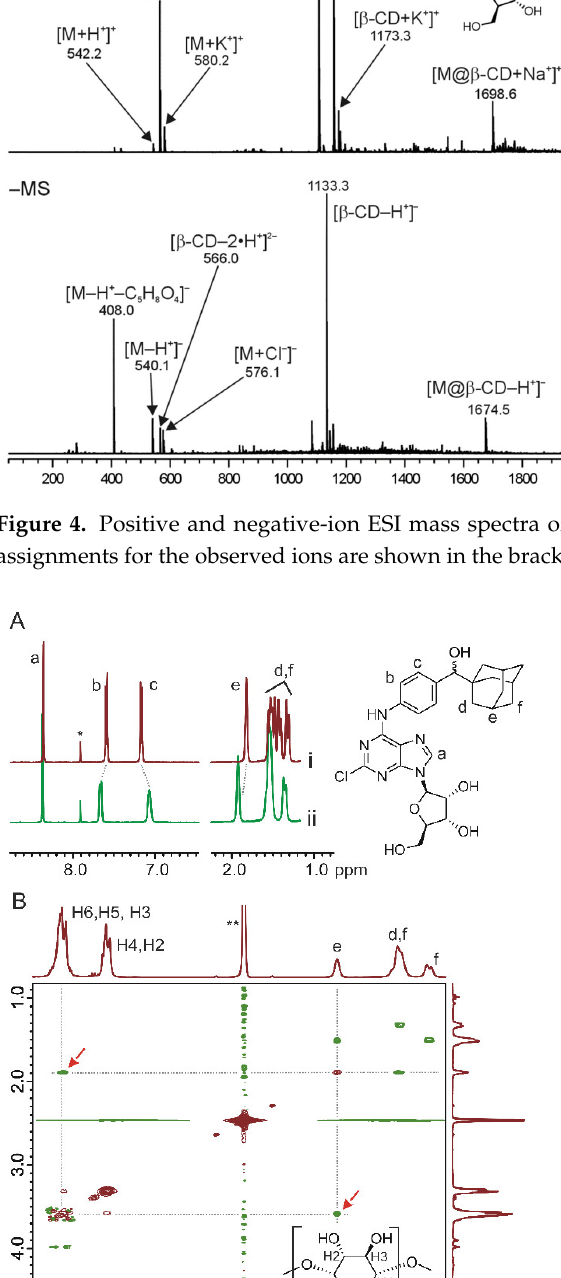
Figure 4. Positive and negative-ion ESI mass spectra of the equimolar mixture of 24 ·β-CD. The assignments for the observed ions are shown in the brackets.